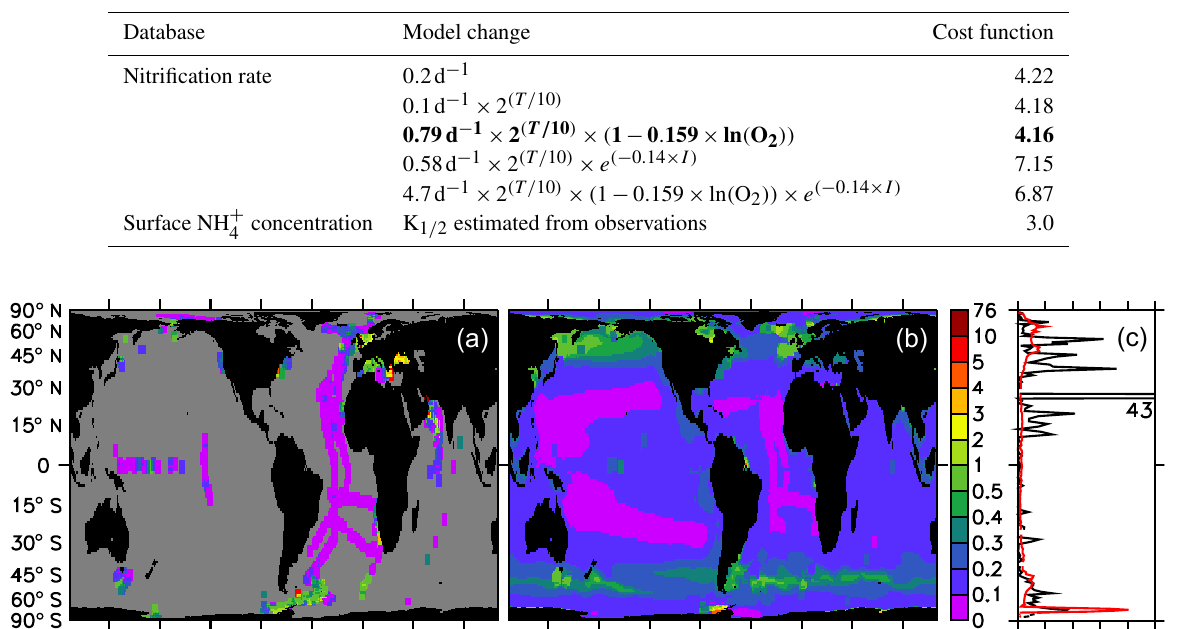
Table 1. Cost function (Eq. 3) for the optimisation simulations of Sect. 2.2–2.4, relative to the respective observational databases. The nitrification rate in bold was used in this study.